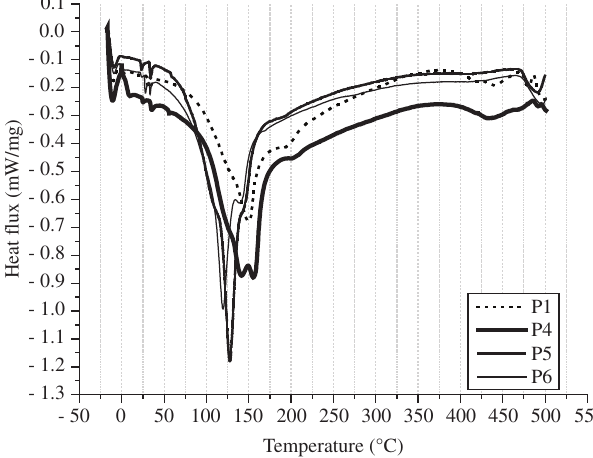
Figure 7. DSC curves of the pastes P1, P4, P5 and